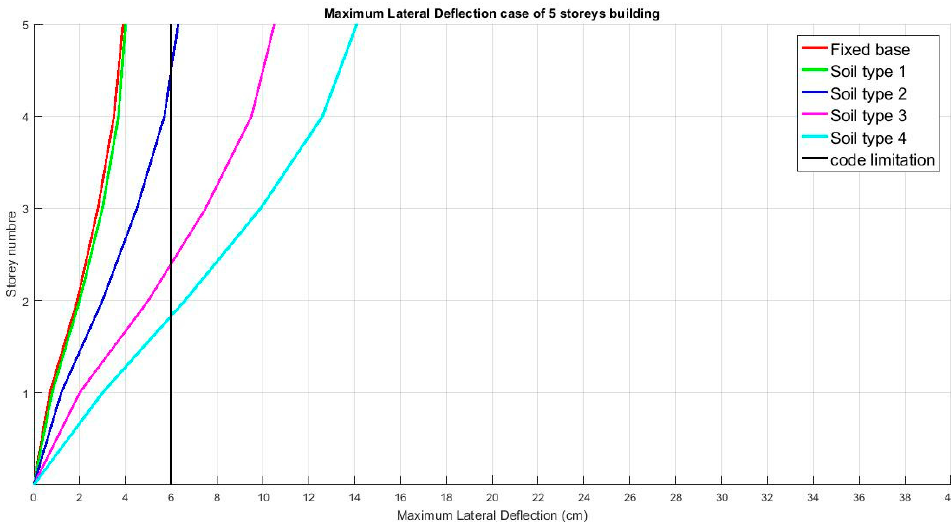
Figure 5. Maximum lateral deflection case of a 5-story building.